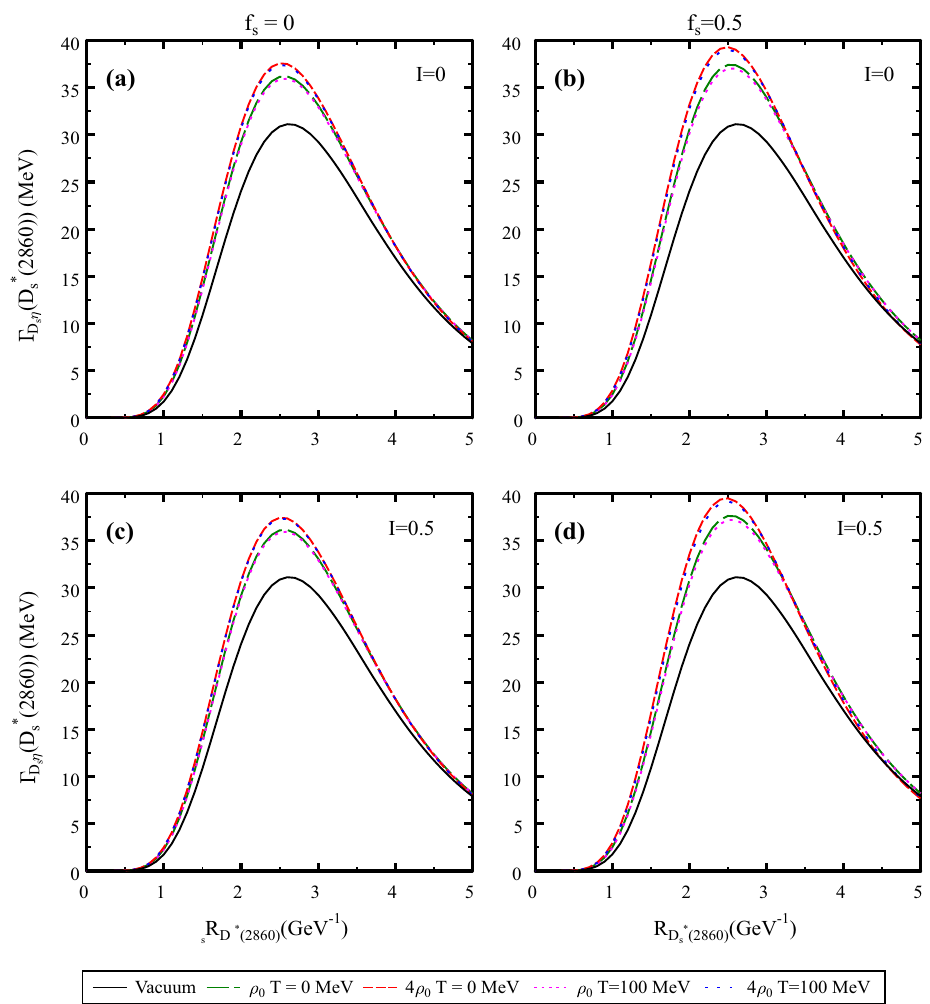
Fig. 7 The variation of partial decay widths of the D ∗ s ( 2860 ) mesons to a pairs of the D s ( 1968 ) and η mesons as a function of R D ∗ two values of baryonic densities ( ρ 0 , 4 ρ 0 ), isospin asymmetric param-